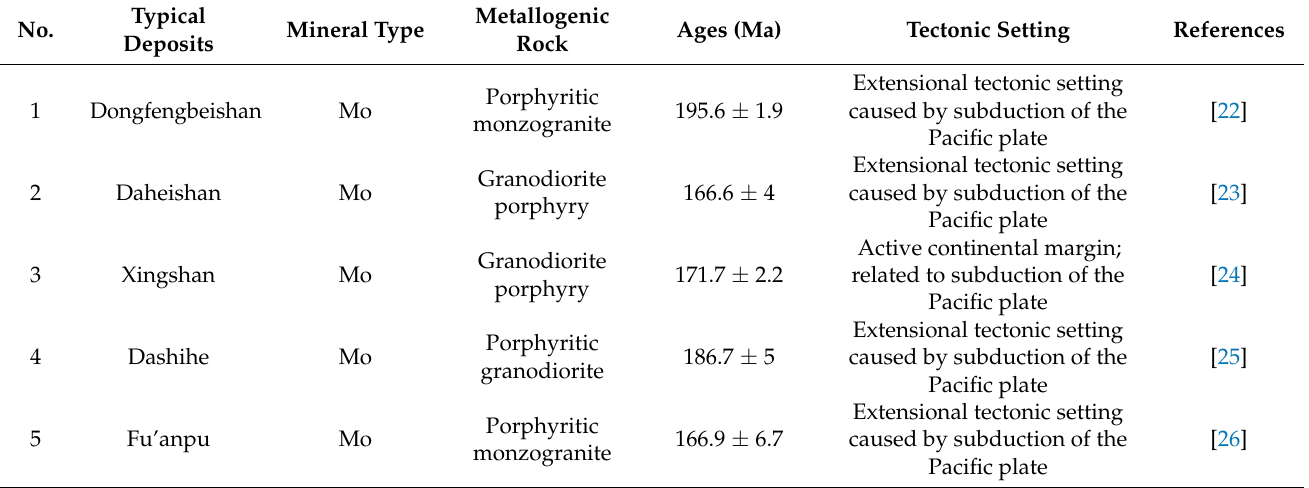
Table 1. Geochronology and tectonic setting of metallogenic porphyry in Early–Middle Jurassic nonferrous metal deposits in NE